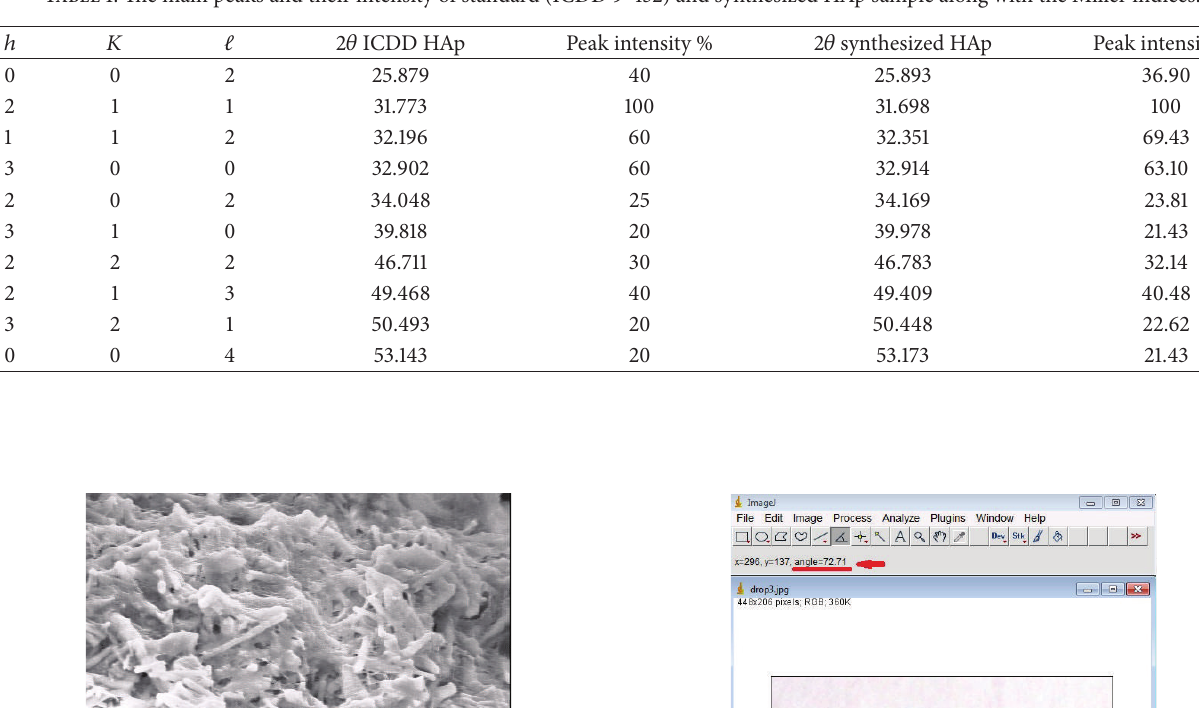
Table 1: The main peaks and their intensity of standard (ICDD 9-432) and synthesized HAp sample along with the Miller indices.